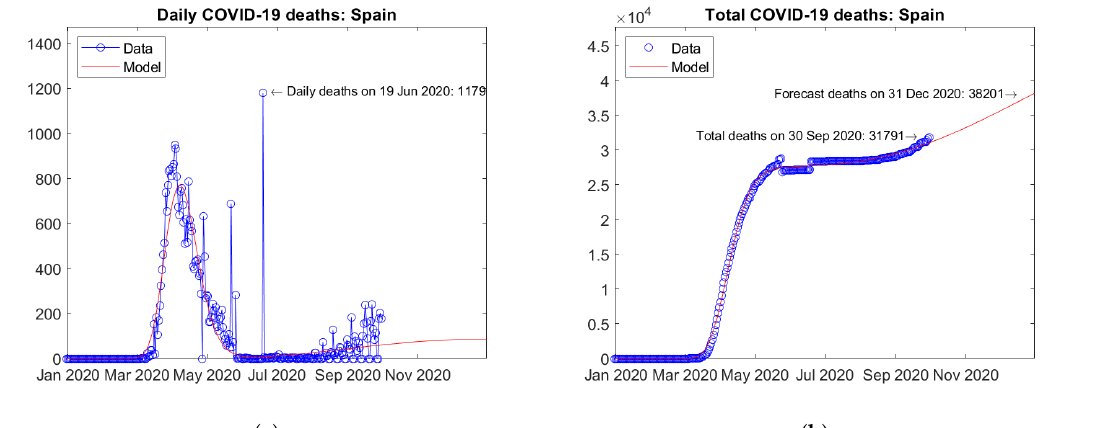
Figure 14. Actual and predicted trends in Spain: ( a ) daily deaths, ( b ) total deaths.